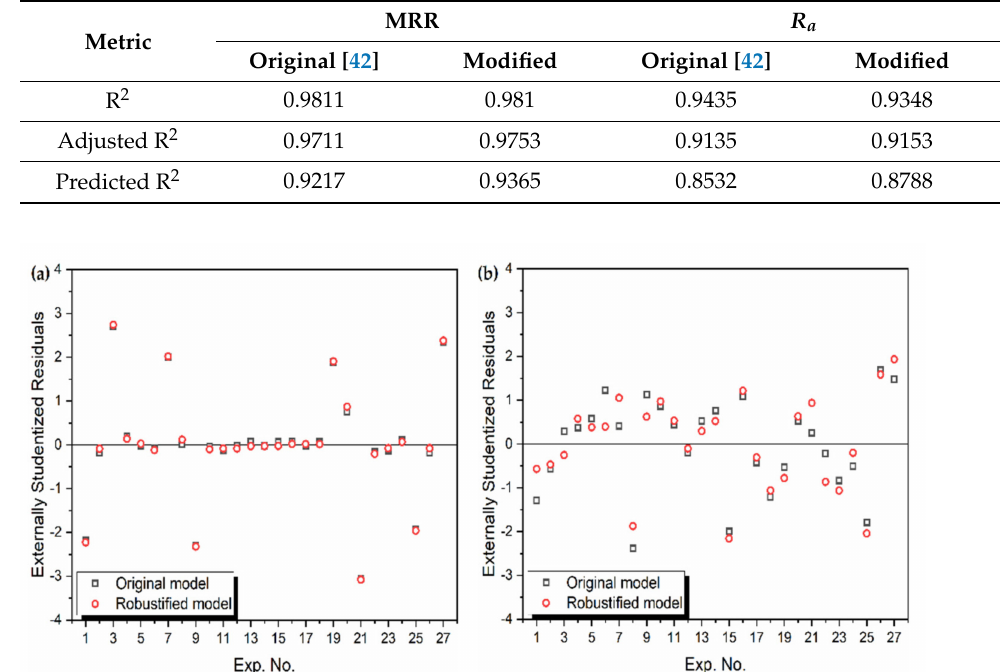
Table 3. Accuracy of the original and modified mathematical models.